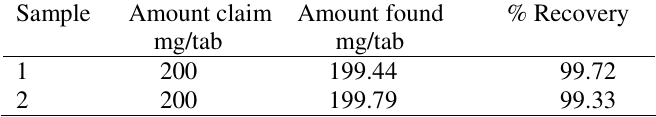
Table 4. Results of assay of formulation by the proposed method Sample